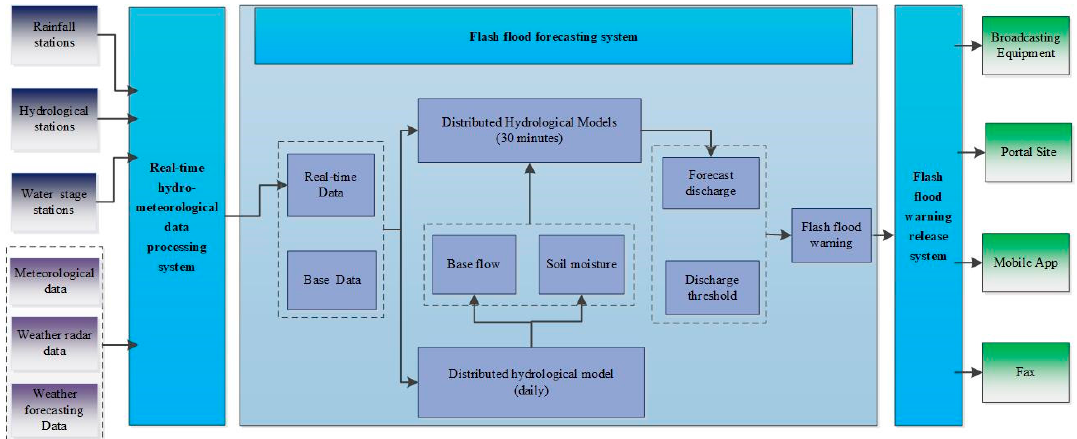
Figure 4. Schematic of the flash flood warning system technical components.